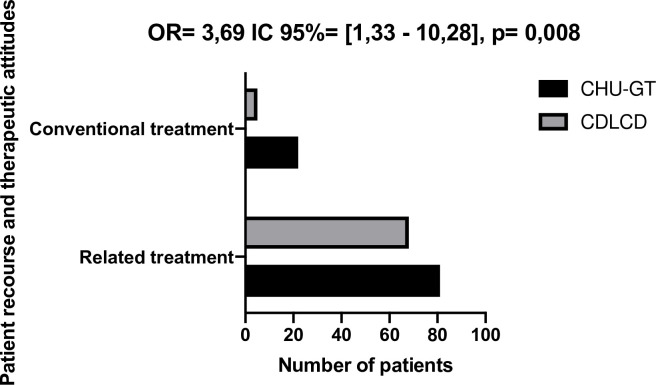
Patients recourse.